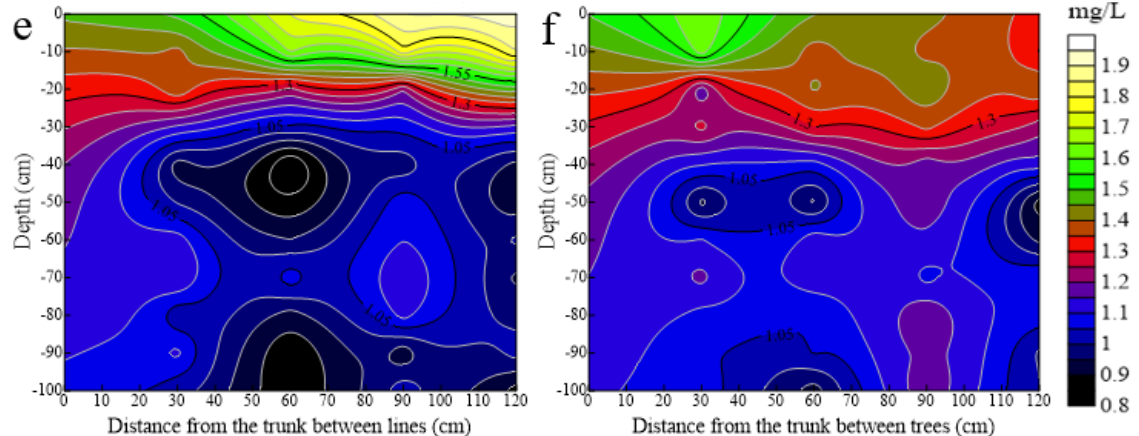
Figure 7. Distribution of nitrogen between rows and trees within the row in the apple root region in October 2016: ( a ) ammonia nitrogen between rows; ( b ) ammonia nitrogen between trees within the row; ( c ) nitrate nitrogen between rows; ( d ) nitrate nitrogen between trees within the row; ( e ) total nitrogen between rows ; and ( f ) total nitrogen between trees within the row.